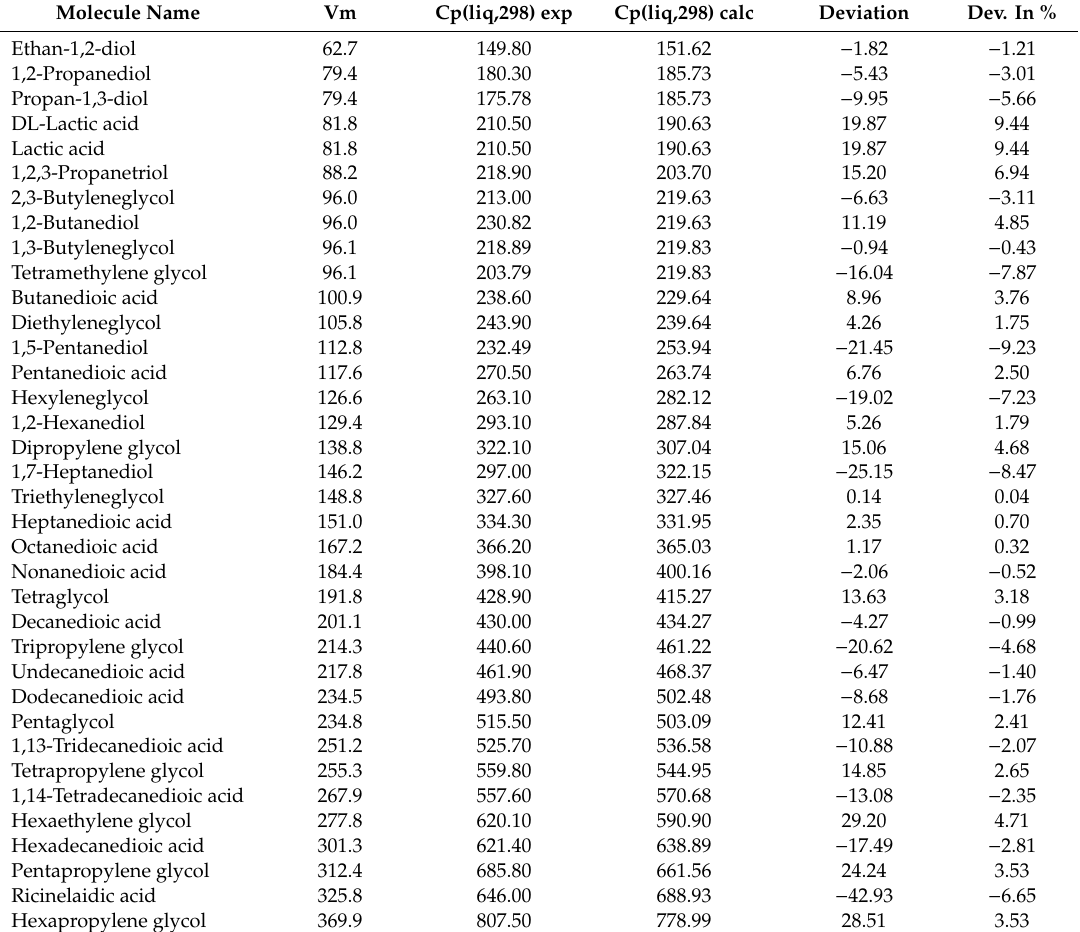
Table 7. Molecular volumes Vm (in A 3 ), experimental and Equation (4)-calculated Cp(liq.298) (in J / mol / K) of 36 polyols and